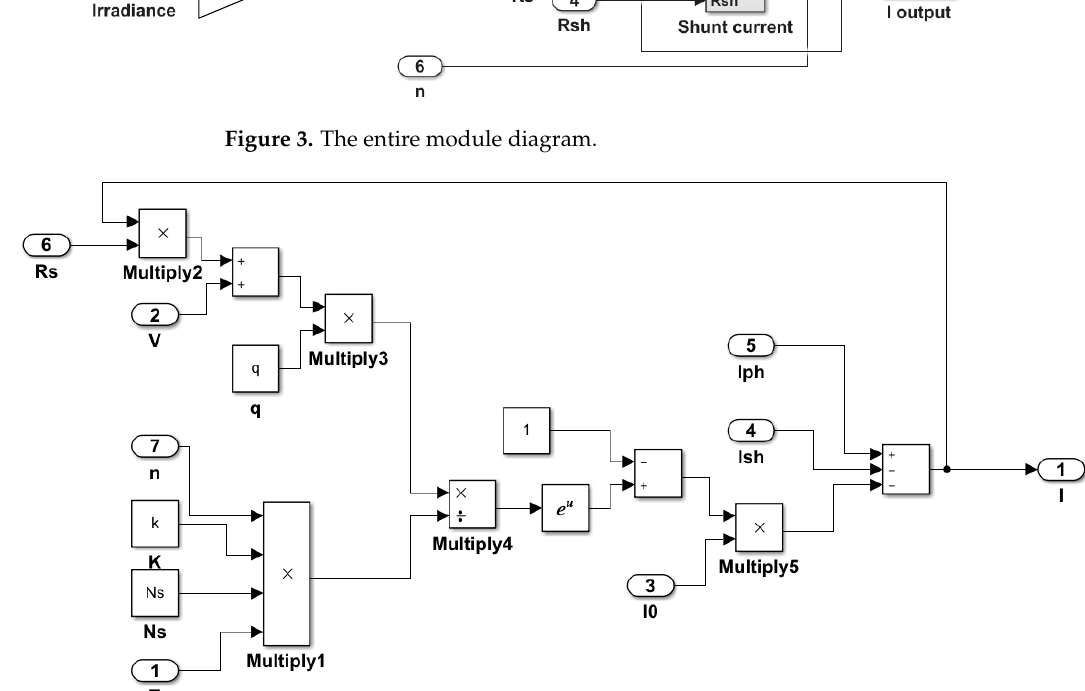
Figure 4. The output current diagram.